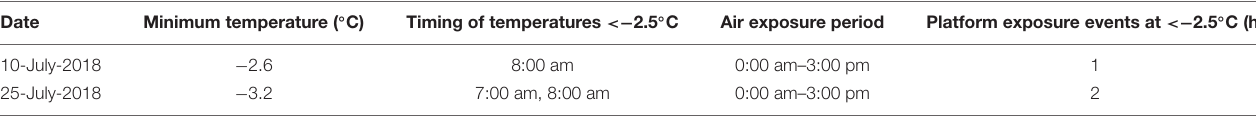
TABLE 4 | Dates with air temperatures below the freezing point of seawater (i.e., − 2.5 ◦ C) and associated platform exposure times quantified as the number of hourly air-exposed temperature records < − 2.5 ◦ C.